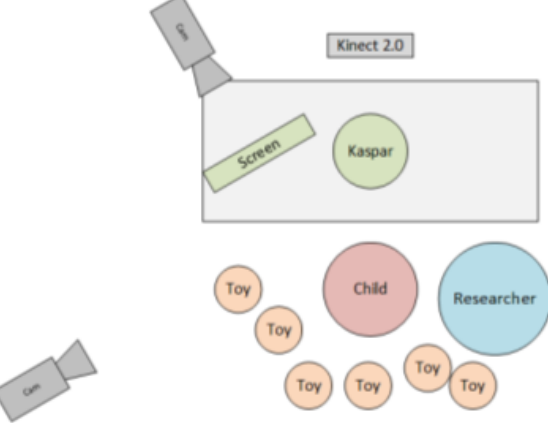
Figure 3: Generic equipment